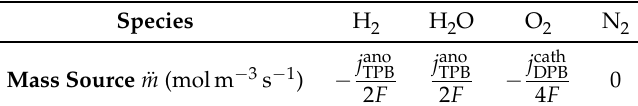
Table 9. Mass sources for Equation (13).